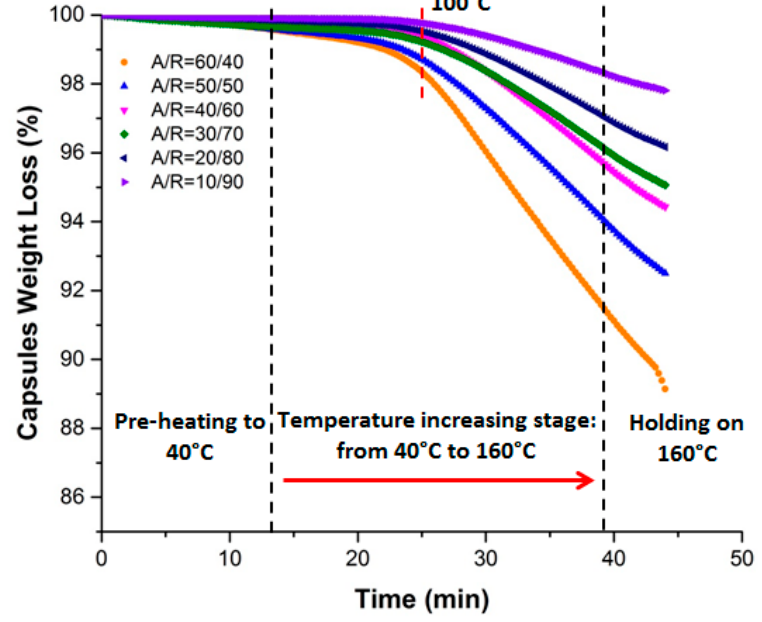
Figure 6. TGA results of capsules fabricated with varying A/R ratios.